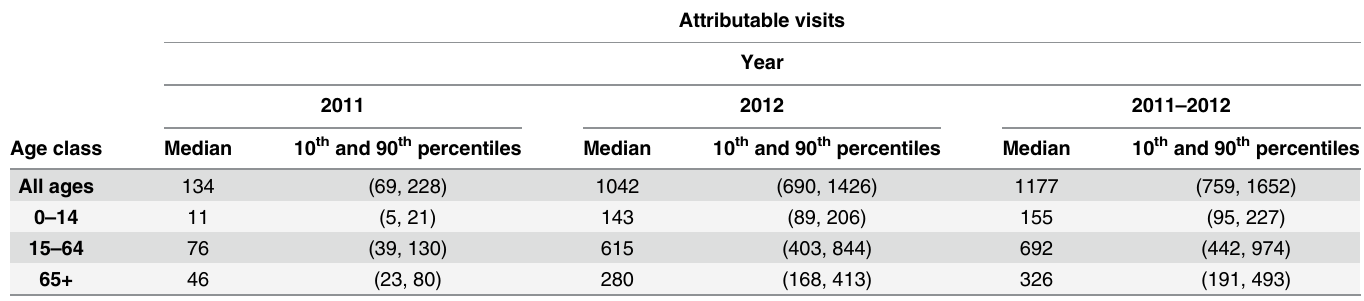
Table 3. Estimated impact of apparent temperature above the threshold on no-white tag visits.